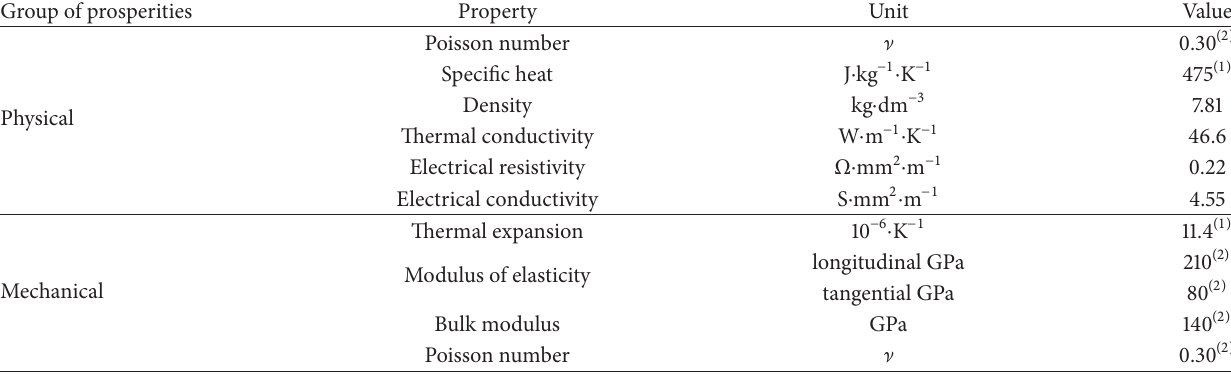
Table 2: Selected physical and mechanical properties of 100Cr6 steel.